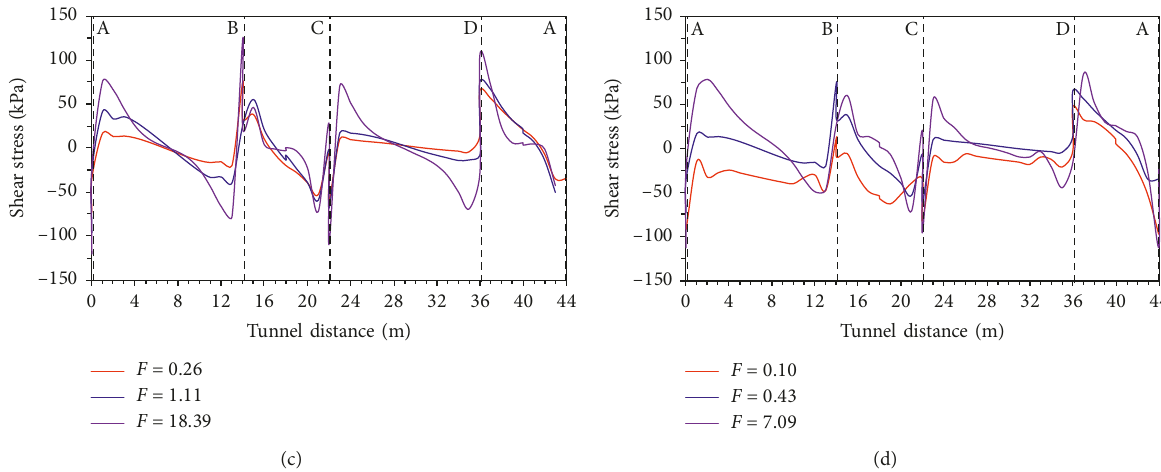
Figure 19: Shear stress distribution (a) at soil elements adjacent to tunnel at time of maximum thrust for (b) Loma Prieta, (c) Nahanni, and (d) Chi-Chi